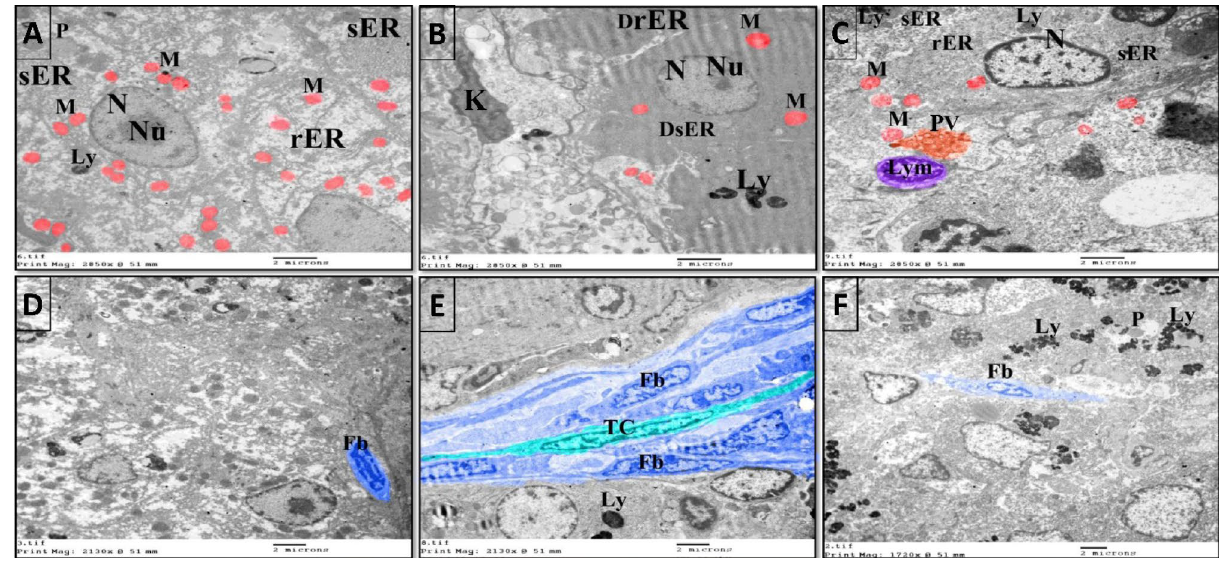
Figure 6. Colored transmission electron photomicrographs illustrating the hepatoprotective effects of NSS against 4-NP-induced hepatotoxicity in Clarias gariepinus using colored transmission electron micrographs. ( A ) Hepatocyte of the control group displaying euchromatic nucleus (N) with distinct nucleolus (Nu), well- developed rough endoplasmic reticulum (rER), well-developed smooth endoplasmic reticulum (sER), abundant mitochondria (M), and few lysosomes (Ly) and peroxisomes (P). ( B ) Hepatocyte of the 4-NP-intoxicated group showing nucleus (N) with decreasing amount of heterochromatin and degenerated nucleolus (Nu), degenerated rough endoplasmic reticulum, degenerated smooth endoplasmic reticulum, Kupffer cells (K), few mitochondria (M), and lysosomes (Ly). ( C ) Hepatocyte of the NSS + 4-NP-treated group displaying euchromatic nucleus (N), nearly healthy rough endoplasmic reticulum (rER), smooth endoplasmic reticulum (sER), mitochondria (M), phagocytic vacuole, and lysosomes (Ly). Note the lymphocyte (Lym). ( D ) Liver of the control group showing few fibroblasts (Fb). ( E ) Liver of 4-NP-intoxicated group showing numerous fibroblasts (Fb). Note the telocyte (TC). ( F ) Liver of NSS + 4-NP treated group showing few fibroblasts (Fb). Note the numerous lysosomes (Ly) and peroxisomes (P) on the hepatocytes.